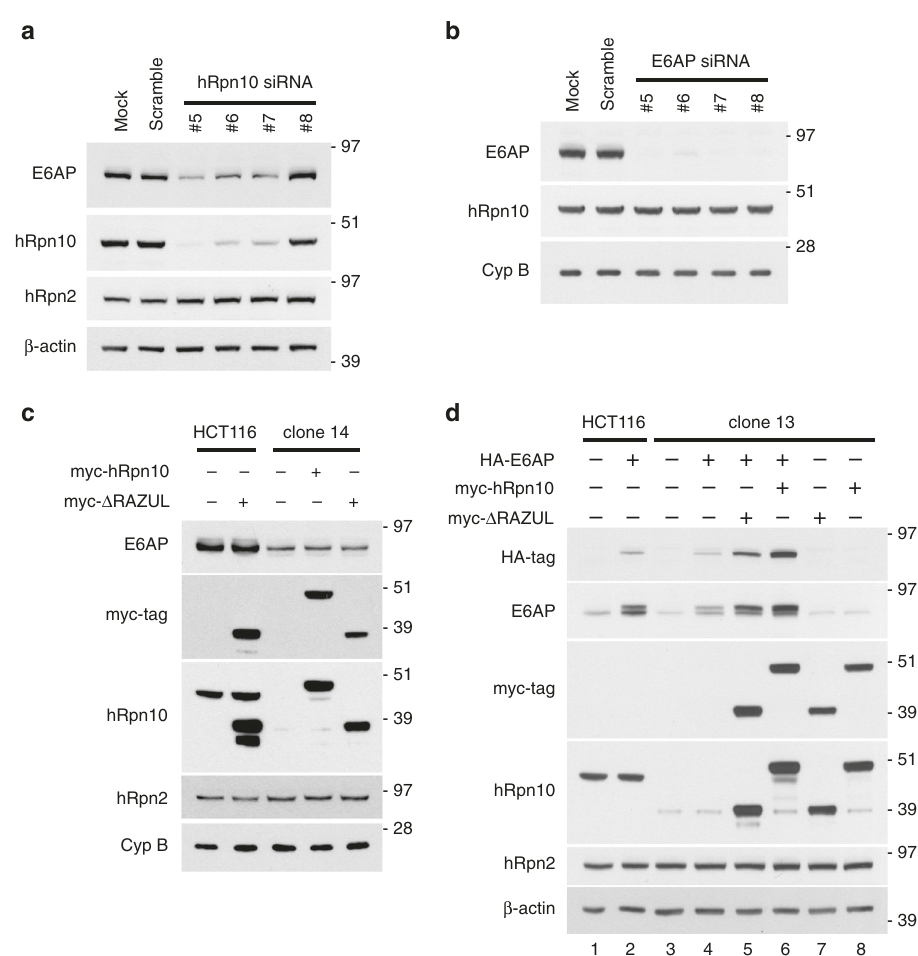
Fig. 3 E6AP levels depend on hRpn10. hRpn10 ( a ) or E6AP ( b ) was knocked down in HCT116 cells by four different siRNAs and the cell lysates immunoprobed as indicated. Mock and scrambled control samples are included. β -actin is used as a loading control in a and d . c Lysates from HCT116 or clone 14 cells expressing myc-hRpn10 constructs were immunoprobed as indicated. d Lysates from HCT116 or clone 13 cells expressing HA-E6AP and/or myc-hRpn10 constructs were immunoprobed as indicated. a – d Antibodies used for immunoprobing are indicated to the left of each panel. Source data are provided as a Source Data fi